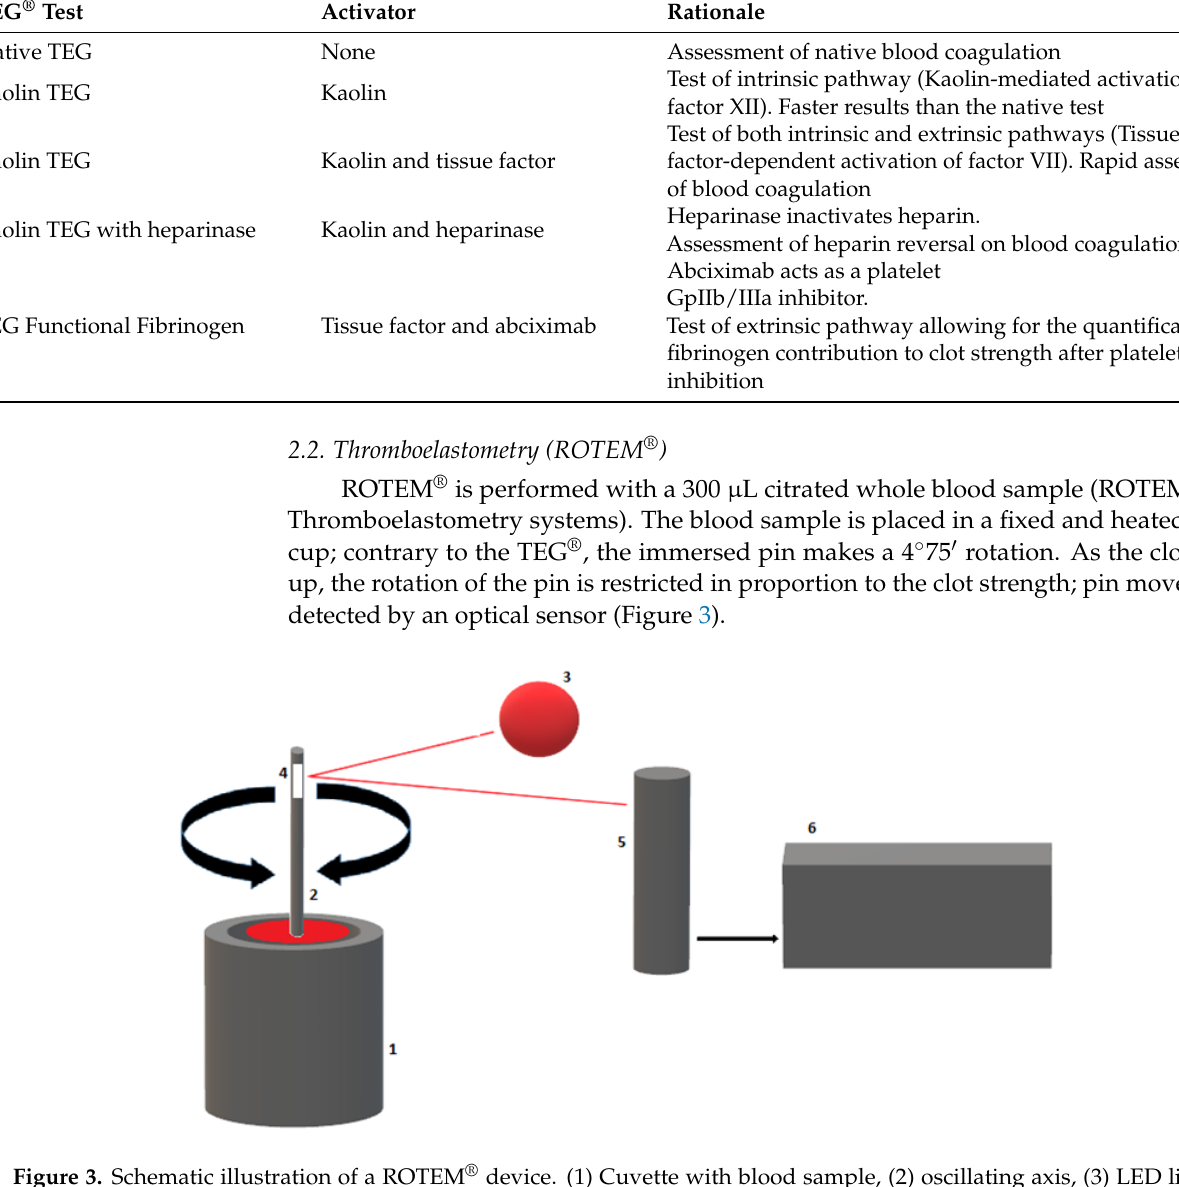
Figure 3. Schematic illustration of a ROTEM ® device. (1) Cuvette with blood sample, (2) oscillating axis, (3) LED light source, (4) mirror, (5) detector, (6) data processing unit.